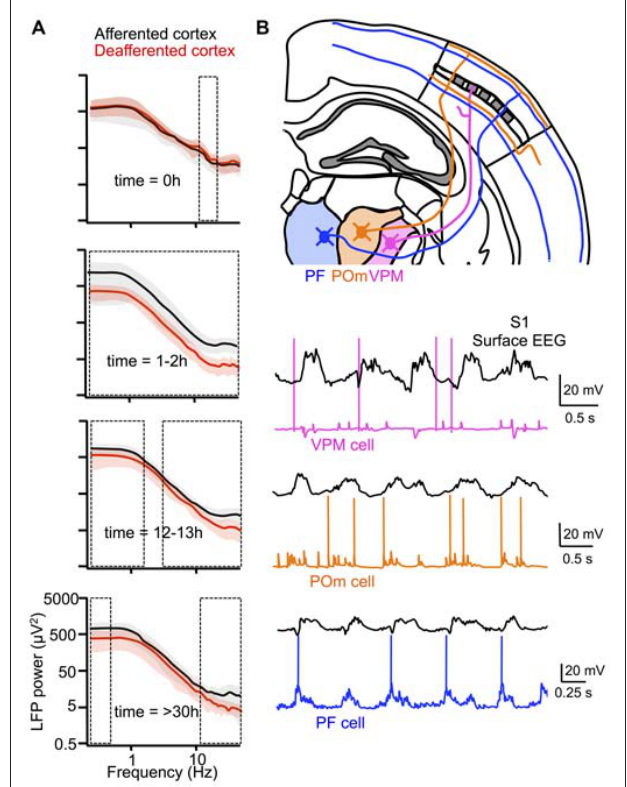
FIGURE 5 | Active thalamic contribution to the cortical slow oscillation. (A) Pharmacological inactivation of thalamic nucleus LP in anesthetized cats resulted in deafferentation of certain regions of suprasylvian gyrus (red), but not others (black). Effects of deafferentation on the slow oscillation were quantified by differences in LFP power. Boxed regions indicate statistically significant ( p < 0.05) frequency bins. The slow oscillation and faster oscillatory activities during Up states were significantly affected within ∼ 12 h after thalamic inactivation, but many aspects of the slow oscillation recovered after 1 day, perhaps due to up-regulation of intracortical synaptic connections. (B) Distinct activities of core (VPM) and matrix (POm and PF) thalamic nuclei during the slow oscillation in anesthetized mouse. VPM cells are strongly inhibited during the slow oscillation, while POm and PF cells are depolarized in phase with the slow oscillation. Thalamic neurons in matrix nuclei may play an active role in the cortical slow oscillation. (A) adapted by permission from the Society for Neuroscience: Journal of Neuroscience (Lemieux et al., 2014), © 2014. (B) adapted by permission from the Society for Neuroscience: